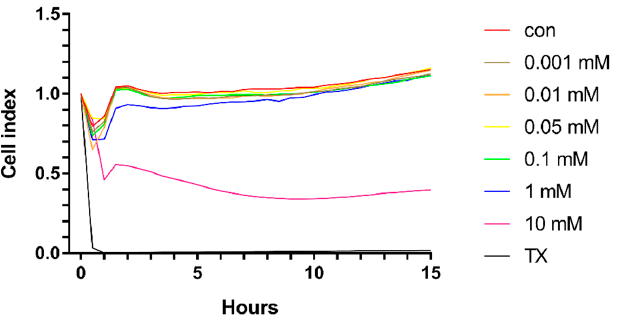
Figure 3. Kinetics of the effect of HPBCD on the viability of hCMEC/D3 cells monitored by impedance measurement.